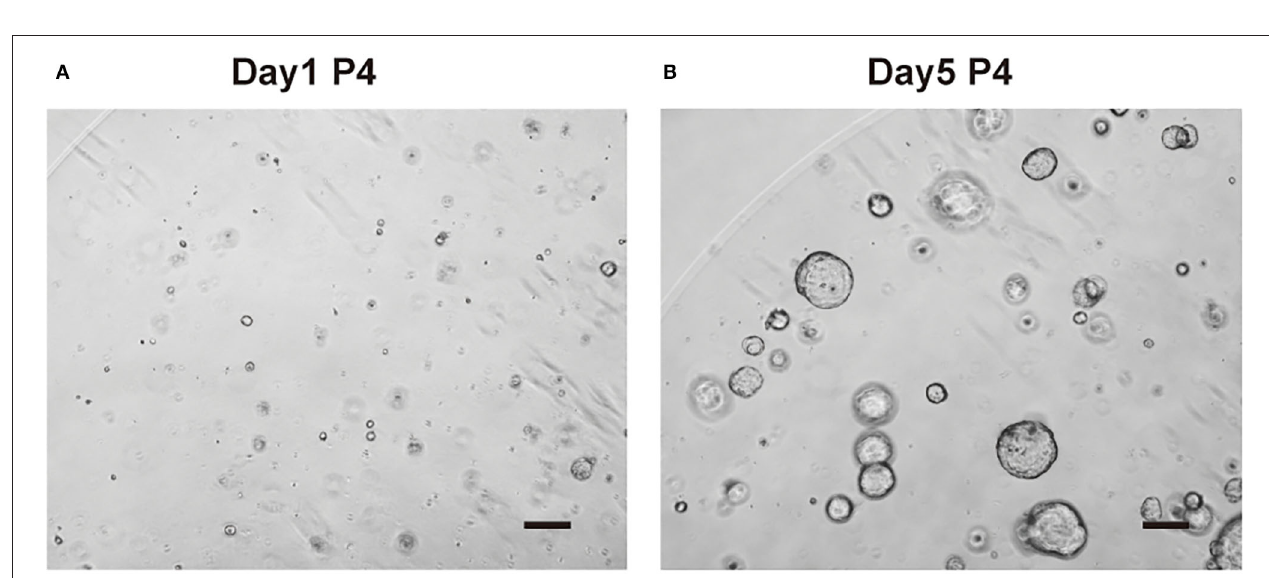
FIGURE 5 | Characteristics of small intestinal organoids (in-orgs). (A) Immunofluorescence staining for the enterocyte cell marker CK20 (red) (bar, 100 µ m). (B) Immunofluorescence staining for the complete tight junction protein CLAUDIN-1 (red) (bar, 100 µ m). (C) Fluorescent dye FITC-dextran-4KD (FD4) absorbing results, observed with a laser confocal Microscope. The in-orgs are on a green background (bar, 100 µ m).